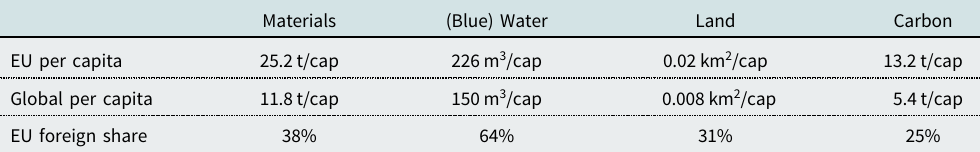
Table 2: The EU-28 ’ s per capita global environmental footprint including percentage derived from non-territorial